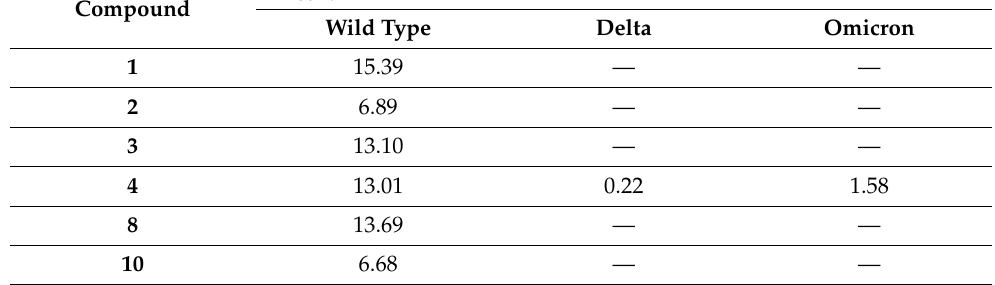
Table 2. IC 50 values of select cyclobutanone derivatives against wild-type as well as Delta and Omi- cron variants for tosyl-L-Trp-cyclobutanone 4 .